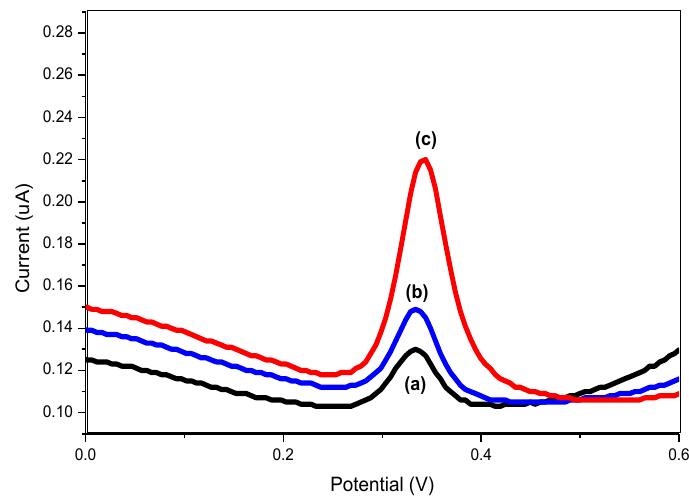
Figure 12. The DPV of ( a ) PANI/GP-DNA probe in non-complementary DNA; ( b ) PANI/GP-DNA probe, and ( c ) PANI/GP-DNA probe-complementary DNA in 0.1 M buffer solution and consisting MB (35 µM).